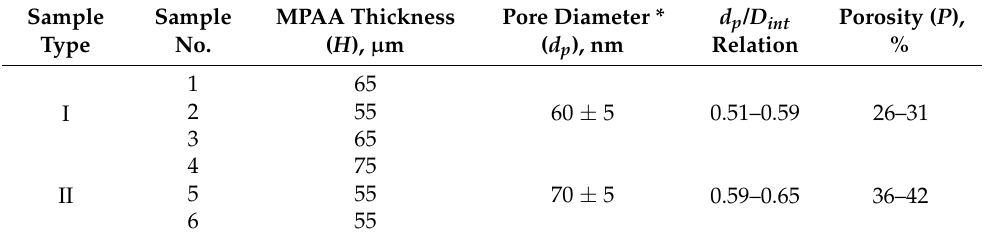
Table 1. The MPAA sample parameters prepared for investigations.